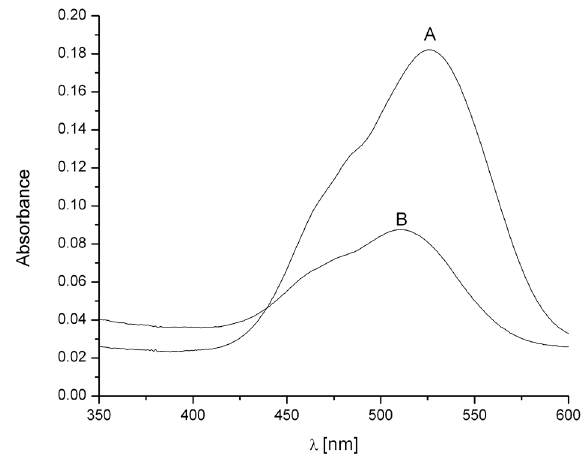
Figure 1: Electronic spectra of the reactant - [Co(ODA)(H the final product [Co(H